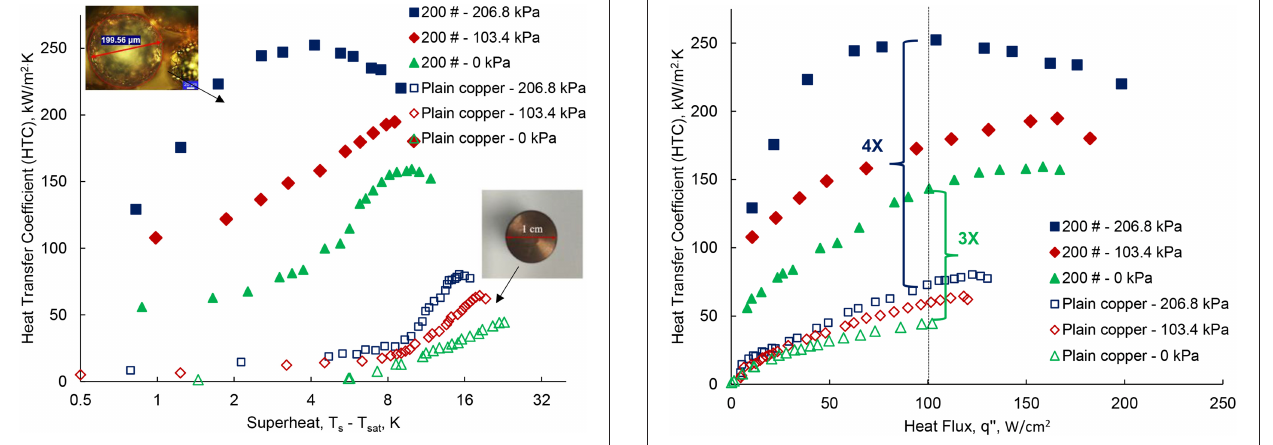
FIGURE 6 | The performance of high-pressure pool-boiling data for three different gauge pressures; 0, 103.4, and 206.8 kPa. Heat Transfer Coefficient (HTC), kW/m 2 K. vs. Superheat T s – T sat (K).